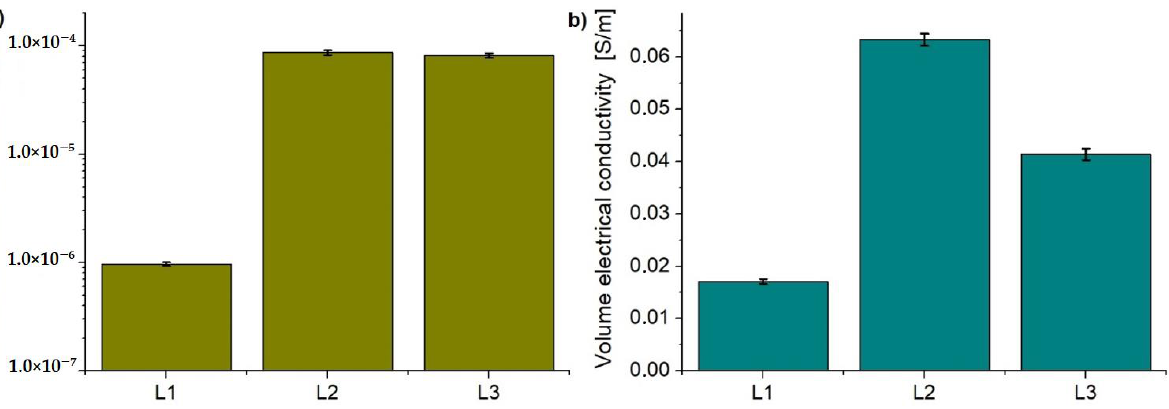
Figure 6. Electrical conductivity of CFRP panels: ( a ) surface, ( b ) Z-direction (through the thickness).